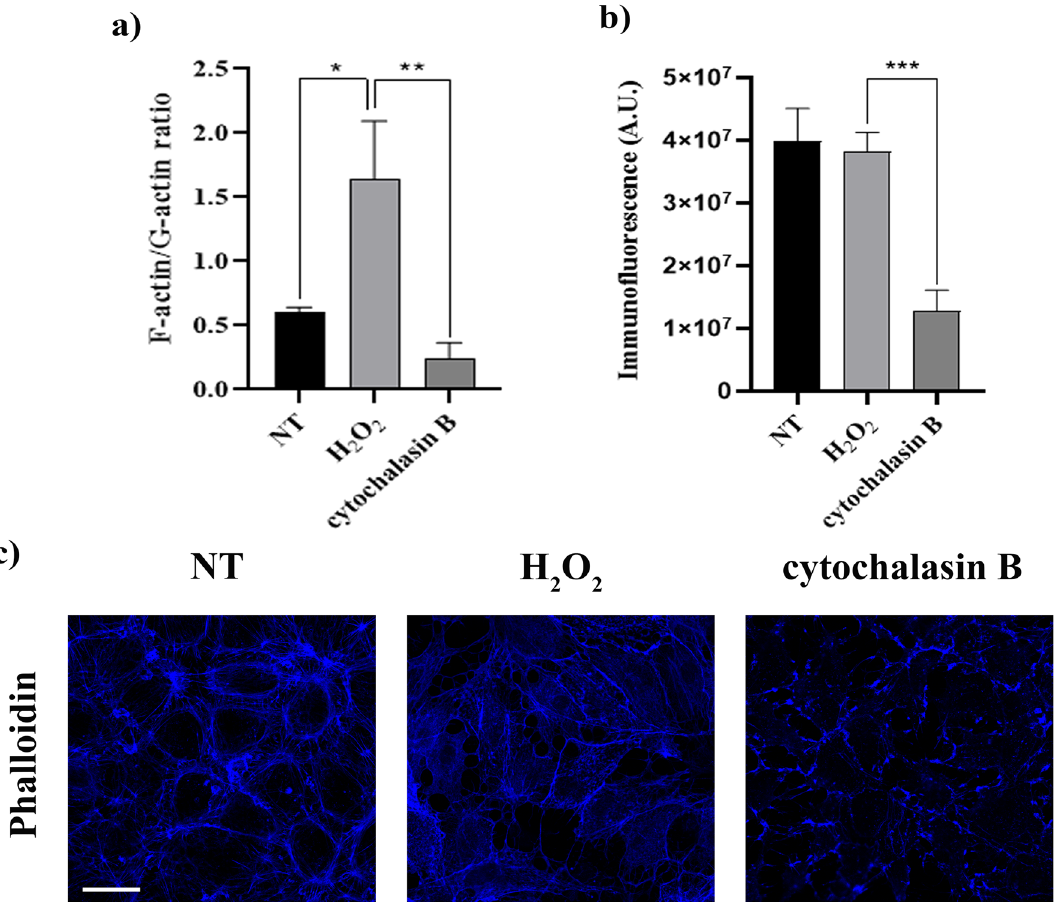
Figure 5. F-actin modification due to oxidative stress. ( a ) F-actin/G-actin ratio was measured by WB analysis in HUVECs stimulated with H (500 µM) for 6h and cytochalasin B (5 μM) for 10 min, a Phalloidin staining (F-actin marker) was performed. Panels in ( c ) show one representative experiment. Scale bar=30µm. F-actin immunofluorescence was quantified by ImageJ-win64. Each measurement included twelve areas of interest per image. A.U., arbitrary units. Data in ( b ) are mean ± s.e.m. of 3 independent experiments, *** P